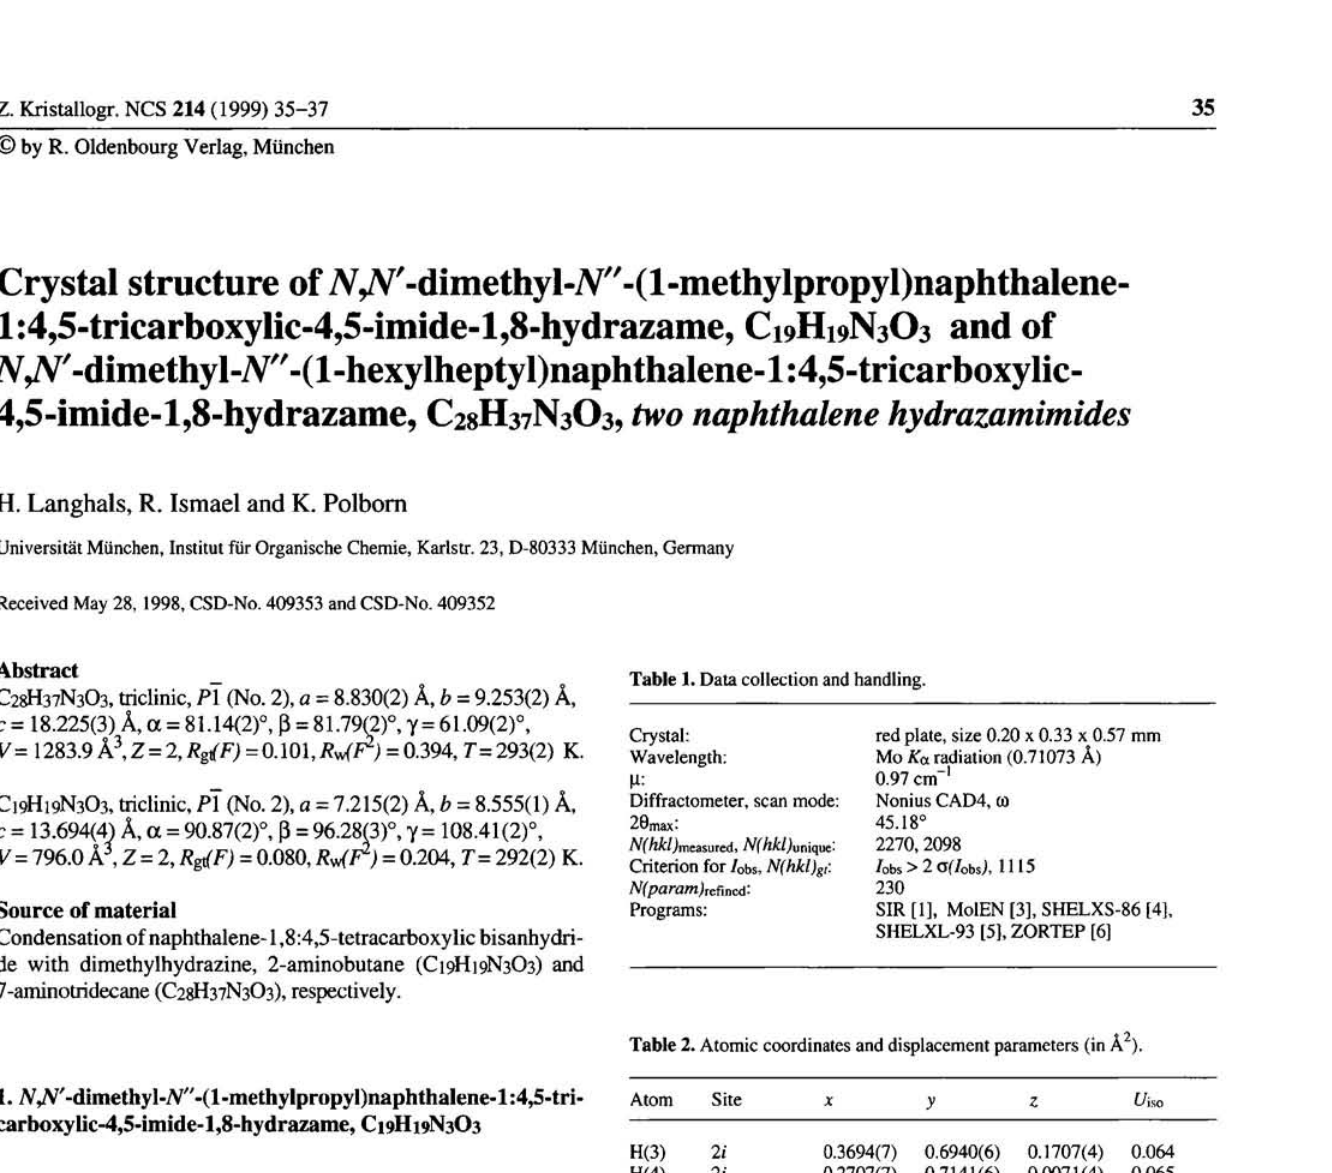
Table 2. Atomic coordinates and displacement parameters (in Â 2 ).